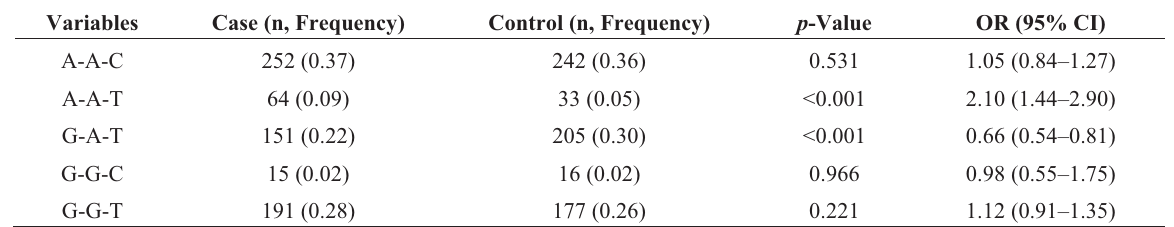
Table 3. Haplotype analysis